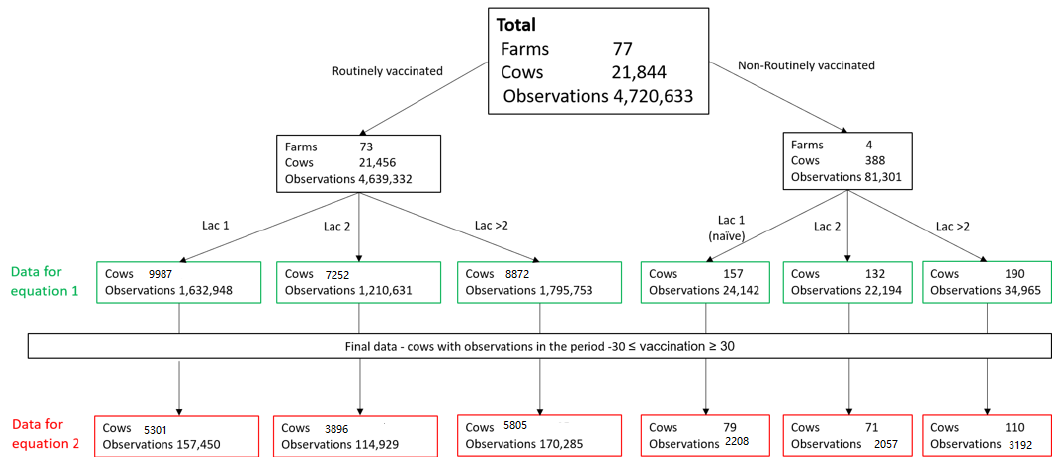
Figure 1. Overall number of observations and cows available for milk production analysis in each lactation group in 77 farms.